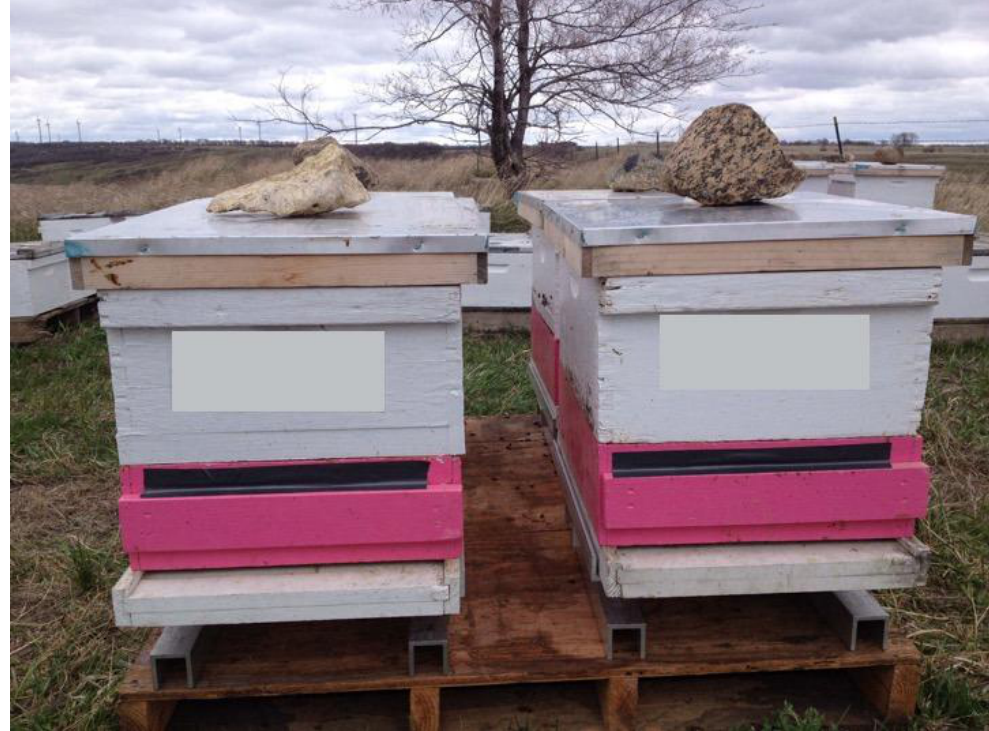
Figure 2. Arrangement of colony monitoring devices. Each colony was fitted with both a pollen trap (pink, above bottom board) and scale (below bottom board). Photo: Clint Otto, USGS-NPWRC.